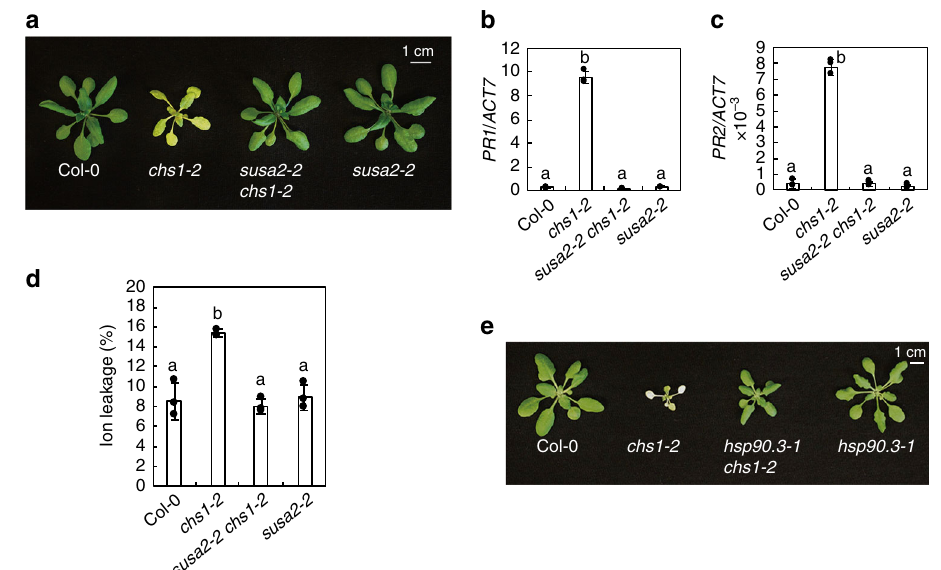
Fig. 5 Both susa2-2 and hsp90.3-1 suppress the temperature-dependent autoimmunity of chs1-2 . a Morphology of 4-week-old Col-0, chs1-2 , susa2-2 chs1-2 , and susa2-2 . Plants were grown on soil for 3 weeks and then moved to 18°C for 1 week to induce the autoimmunity of chs1-2 26 . b , c RT-PCR analysis of the expression of PR1 ( b ) and PR2 ( c ) in the indicated genotypes. ACT7 was used to normalize the transcript levels. Error bars represent means ± SD (one-way ANOVA, SPSS Statistics, n = 3, p <0.01). Experiments were repeated three times with similar results. d Ion leakage measurement of the plants as shown in a . Ion leakage was calculated as the percentage of the conductivity before autoclaving over that after autoclaving. Eight leaf discs were used per genotype in 22.5ml H 2 O. Error bars represent means ± SD (one-way ANOVA, SPSS Statistics, n = 3, p <0.01). Experiments were repeated three times with similar results. e Morphology of 4-week-old Col-0, chs1-2 , hsp90.3-1 chs1-2 , and hsp90.3-1 plants. Plants were grown on soil for three weeks and then moved to 18°C for 1 week before the picture was overexpression are WT like and none display autoimmunity (Supplementary Fig. 11A, B), indicative of the requirement of SUSA2 for SAUL1 overexpression autoimmune responses. Simi- larly, we also examined whether HSP90.3 is required for SAUL1